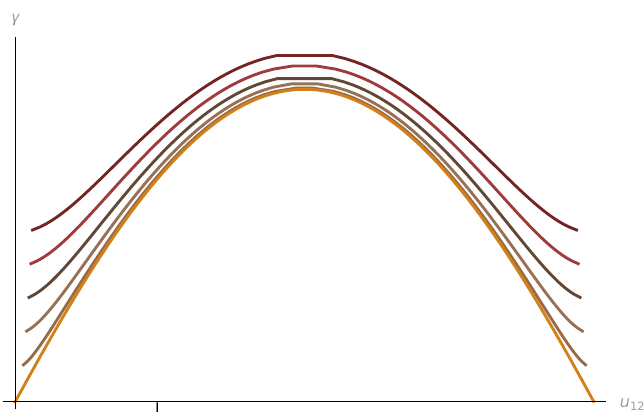
Figure 14 . The precise answer for (cid:13) ( u 12 ) (from red to orange) gets closer to the small (cid:15) approxi- mation (light orange) as (cid:15)